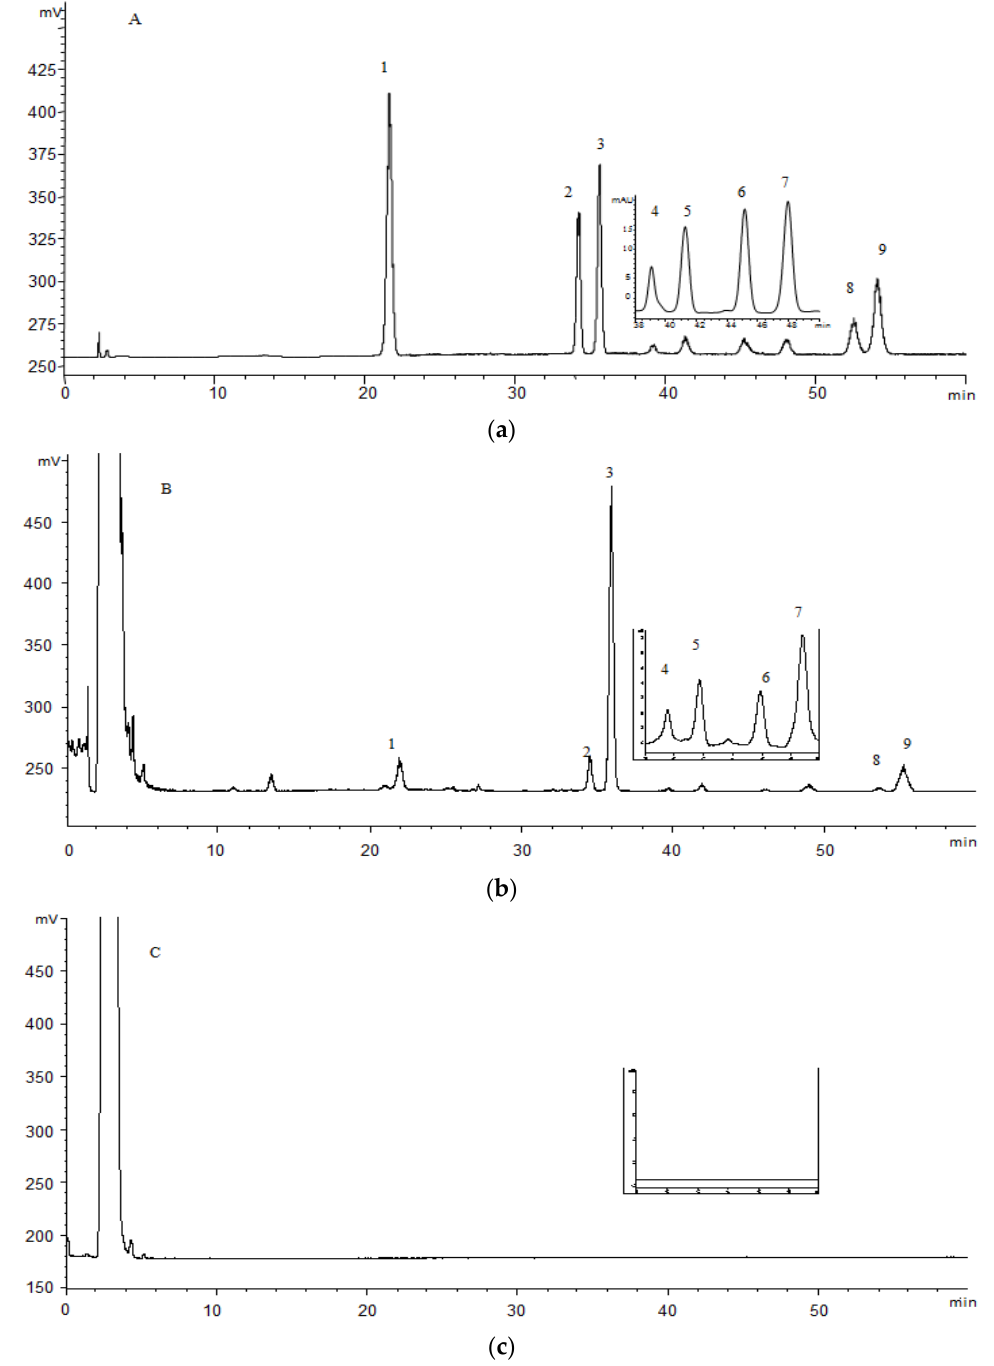
Figure 2. Representative chromatograms of mixed standards ( a ), the leaves ( b ) and fruits ( c ) of P. guajava Representative chromatograms of mixed standards ( a ), the leaves ( b ) detected by ELSD. The embedded chromatograms at 38–50 min are detected by the DAD at 310 nm: asiatic and fruits ( c ) of P. guajava detected by ELSD. The embedded chromatograms at acid ( 1 ), maslinic acid ( 2 ), corosolic acid ( 3 ), 3β- O -cis- p - coumaroyl -2α-hydroxy-olean-12-en-28-oic acid ( 4 ), 38–50 min are detected by the DAD at 310 nm: asiatic acid ( 1 ), maslinic acid ( 2 ), corosolic acid ( 3 ), 3 β - O -cis- p - coumaroyl -2 α -hydroxy-olean-12-en-28-oic 3 β - O - cis - p - coumaroyl -2 α -hydroxy-urs-12-en-28-oic acid ( 5 ), 3 β - O - trans - p -coumaroyl-2 α -hydroxy-olean- 12-en-28-oic acid ( 6 ), 3 β - O - trans - p - coumaroyl -2 α -hydroxy-urs-12-en-28-oic acid ( 7 ), oleanolic acid ( 8 ) and ursolic acid ( 9